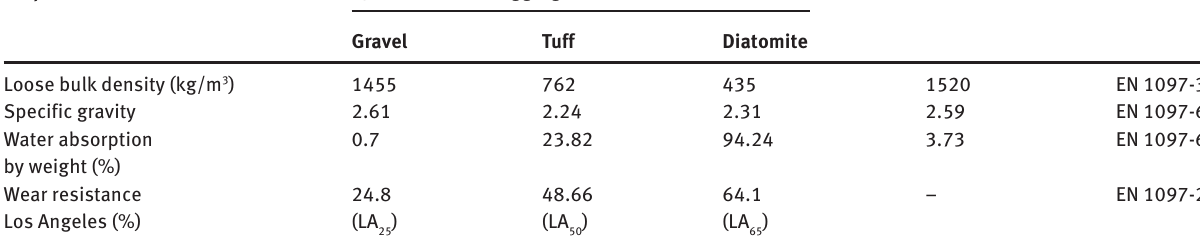
Table 2 Characteristic properties of aggregates.